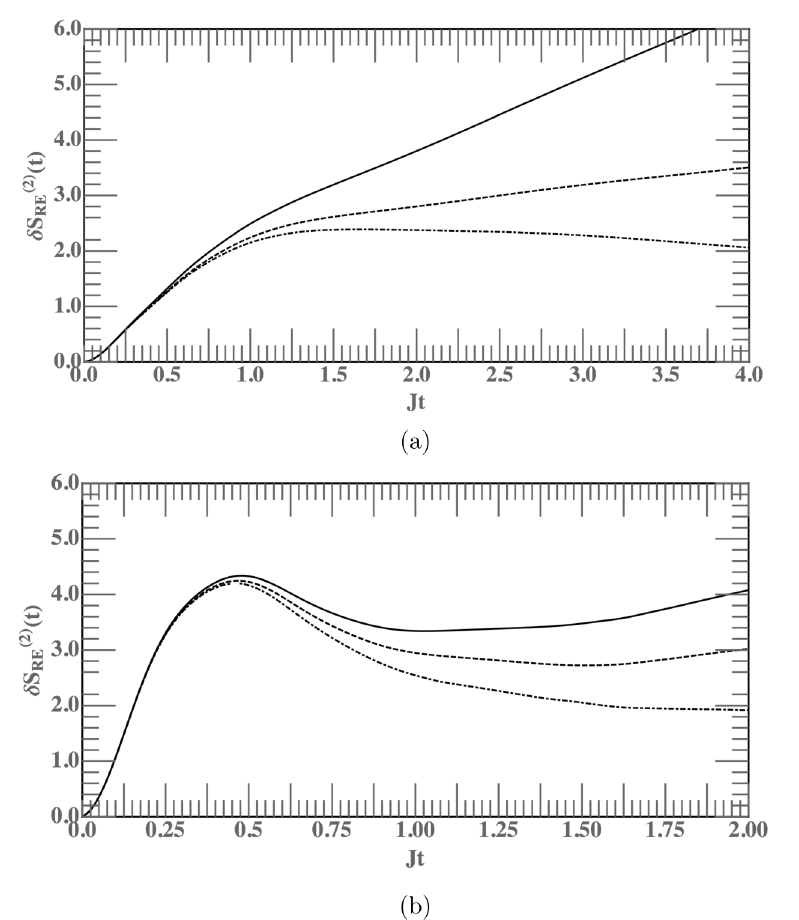
Figure 6 . In (a) we show the RE response for environment with gapless spectrum, β = 10 , J = 4 , β E = 4 . 5 , 8 and 12 respectively with solid line, dashed line and dot-dashed line, J 0 = 0 . 8 ; in (b) we show an oscillation behavior of δS (2) when β E ≈ β . Here β is fixed as 10 . Here the solid line has a RE temperature β E = 4 . 5 . The dashed line is at the temperature β E = 8 and the dot-dashed line is at the environment temperature β E = 12